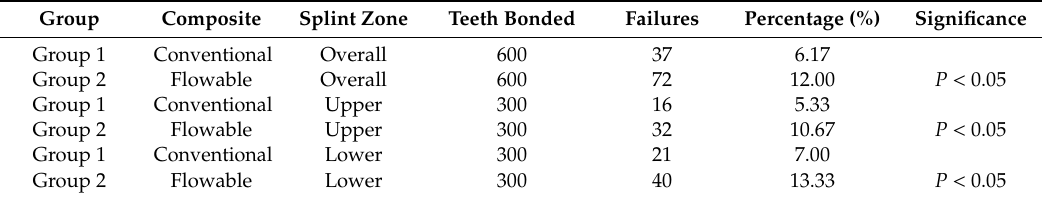
Table 4. Numbers and failure rates of fixed retainers for the overall, upper, and lower teeth in the two groups tested.